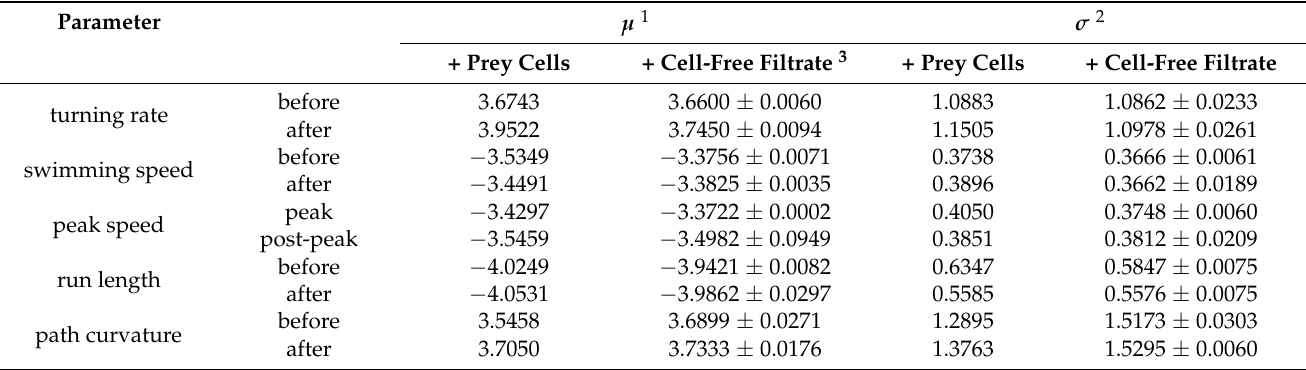
Table 1. Parameter estimation of the fitted curves using the log-normal distribution based on the frequency distributions of movement pattern of Oxyrrhis marina in response to food supply.